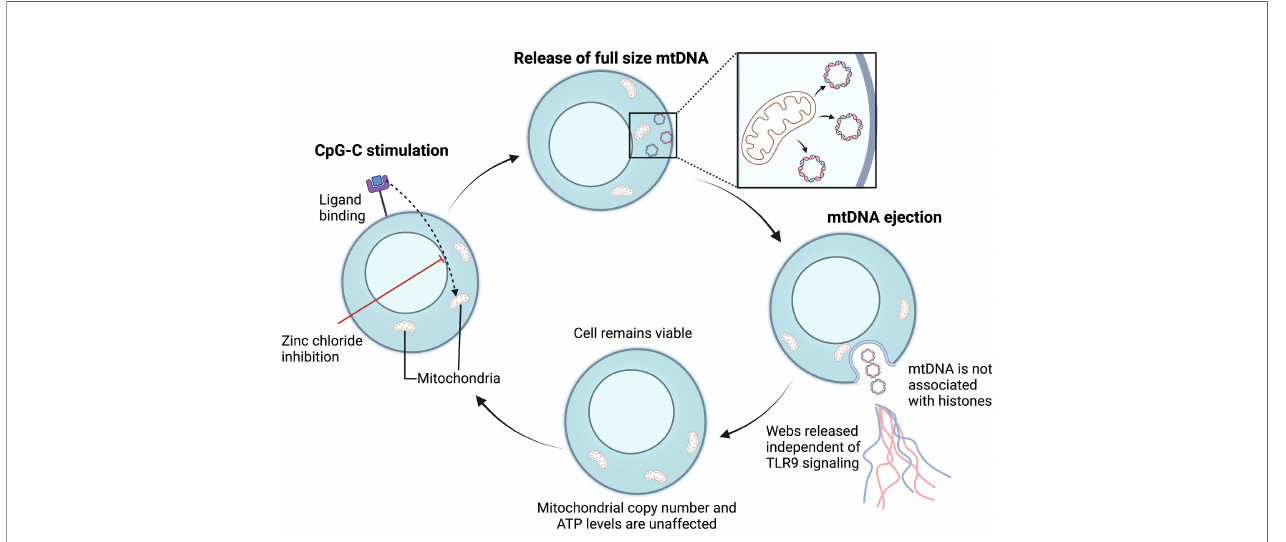
FIGURE 4 | Proposed mechanism for mitochondrial vital TET formation. In B cells, CpG-C activation initiates the ejection of full-sized mtDNA that is free of histones (133). Free mtDNA enters the extracellular space in a web-like con fi guration, independent of TLR-9 activation. Following mtDNA ejection, the cell membrane is preserved, and the number of mitochondria remain unaffected. The cycle is repeated upon CpG-C re-stimulation and mtDNA release is an active process. Whether bacterial ligands can also induce ETs composed of mtDNA in T cells warrants further investigation. mtDNA, mitochondrial DNA; TLR, Toll-like receptor; ATP, Adenosine triphosphate; CpG-C, Synthetic short single-stranded DNA molecules made of cytosine triphosphate deoxynucleotide. Created with